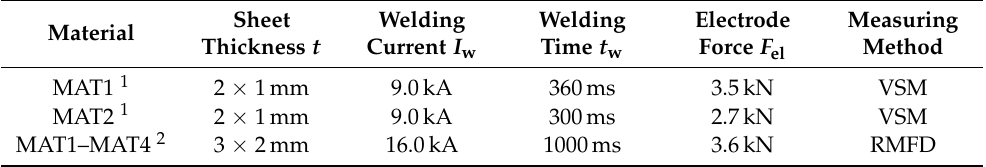
Table 3. Welding parameters used to produce the samples for the methods VSM and RMFD.